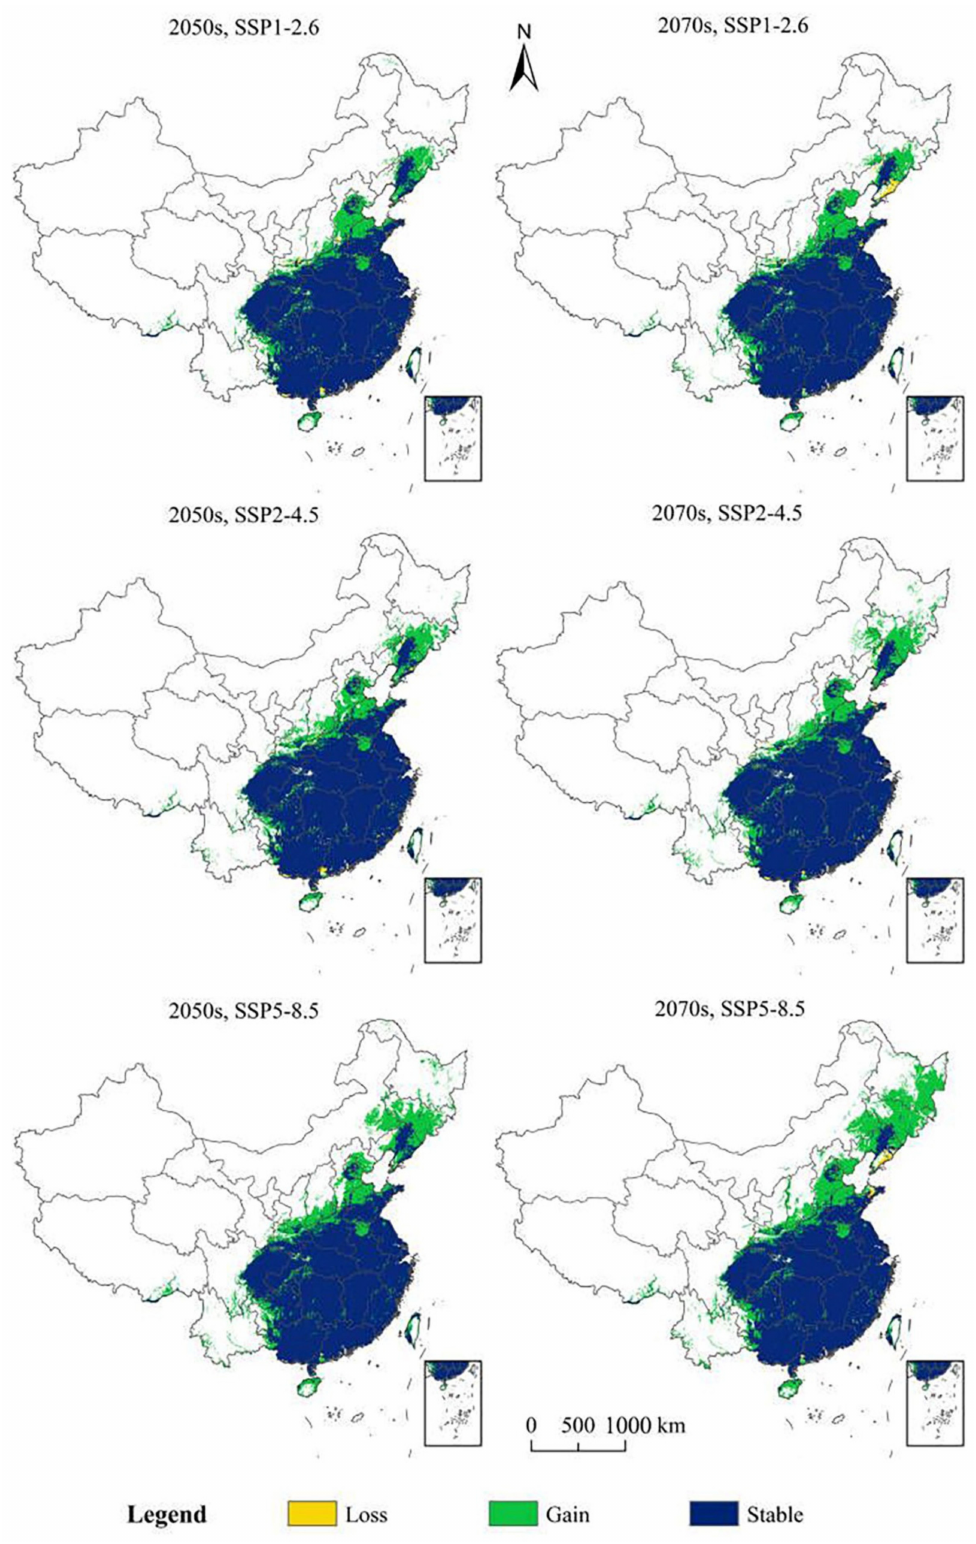
Figure 5. Changes in potentially suitable pine wilt disease habitat under various climate change scenarios in